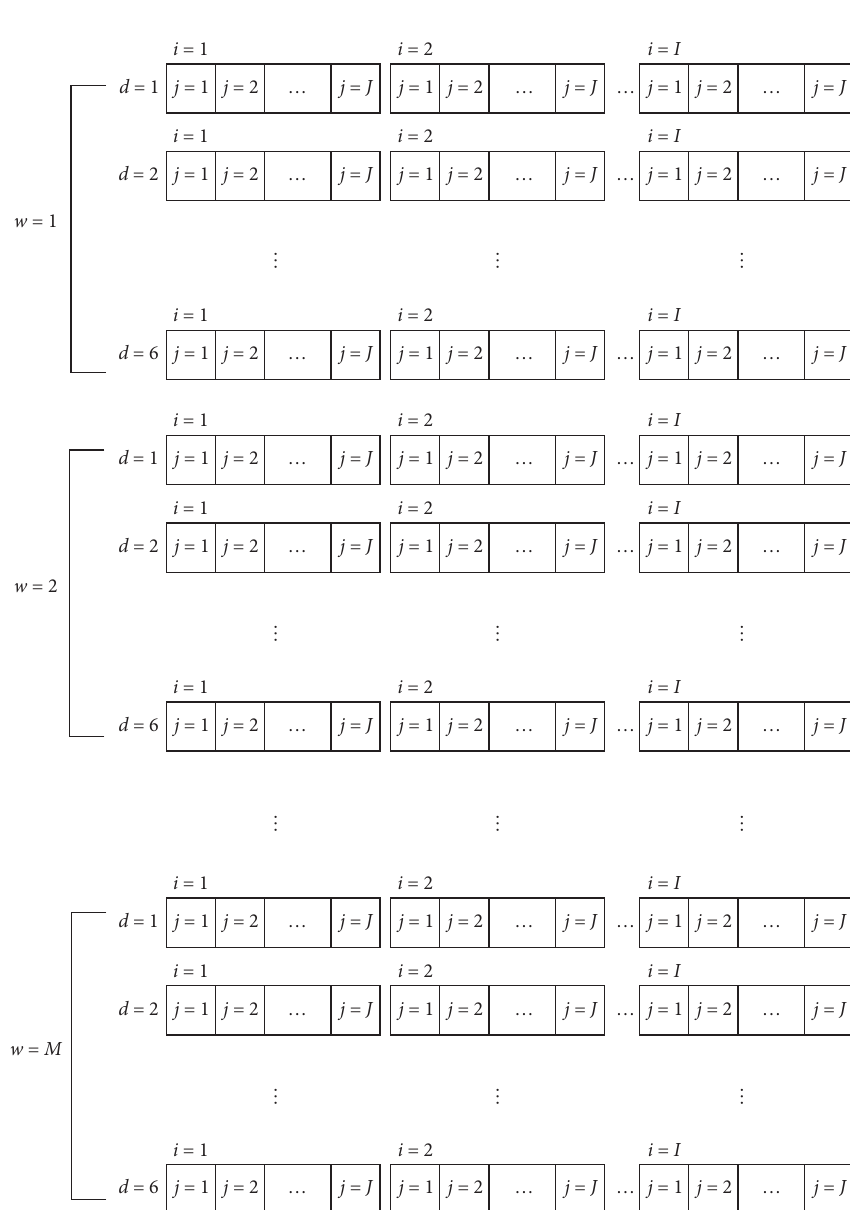
Figure 2: An illustrative solution of the integrated rostering and scheduling